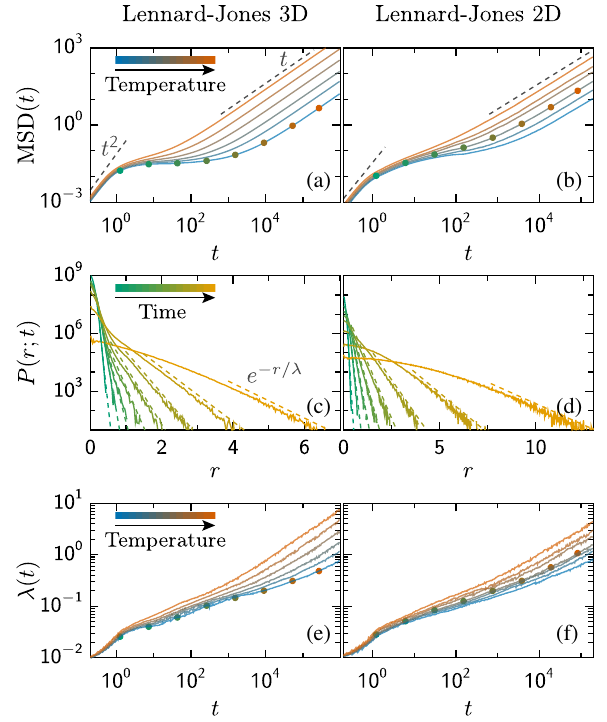
FIG. 1. MSD and exponential tails for the Kob-Andersen binary mixture. (a) MSD for the 3D system at different temperatures from the liquid state to the deep supercooled regime: T ¼ 0 . 7 , 0.6, 0.54, 0.50, 0.475, and 0.45. (b) MSD for the 2D system at different temperatures covering a similar range as in (a): T ¼ 0 . 6 , 0.50, 0.45, 0.40, 0.36, and 0.34. The unit of length is equal to the particle diameter (see Sec. VI for the definition of the time and temperature units). Normalized self-part of the van Hove function P ð r ; t Þ for the 3D system at T ¼ 0 . 45 (c) and for the 2D system at T ¼ 0 . 40 (d), where the selected times are marked by dots in the corresponding MSD in (a) and (b). Dashed lines in (c) and (d) show the extent of the exponential range. Characteristic length λ as a function of time for the 3D (e) and 2D (f) systems: In both cases, temperatures are as in (a) and (b), respectively. Again, dots signal those times corresponding to P ð r ; t Þ in (c) and